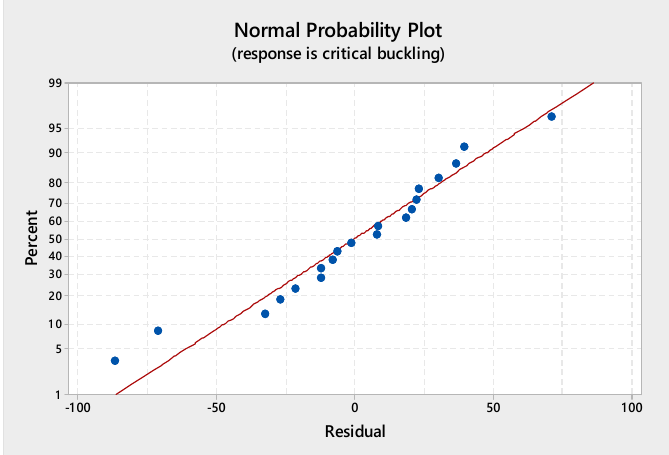
Figure 9. Normal probability plot. Contour Plot of critical buckling vs orientation, layers